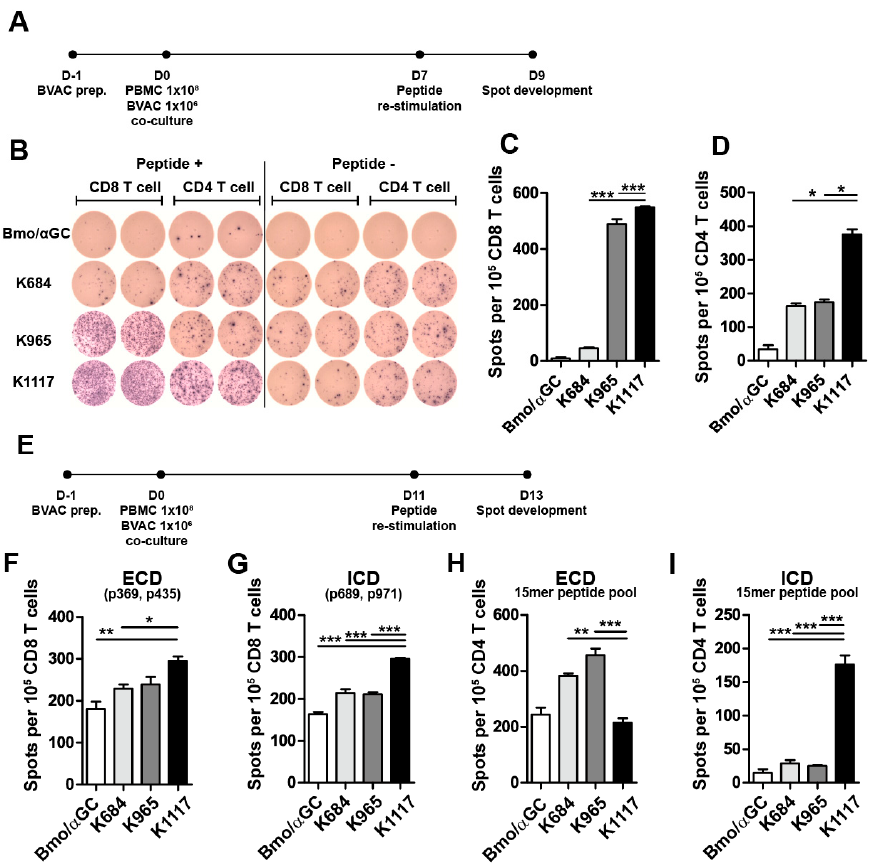
Figure 5. Human T cell responses against HER2. Human PBMCs from human leukocyte antigen (HLA) undefined donors were cocultured with autologous BVACs with engineered antigens ( A ). After 7 days, the CD8 and CD4 T cells were sorted from cocultured PBMCs and restimulated with a total HER2 peptide pool, and IFN- γ production was measured with an ELISPOT assay ( B – D ). ( E ) Human PBMCs carrying HLA-A*0201 were obtained by leukapheresis from a healthy donor and cocultured with autologous BVACs with engineered antigens. After 11 days, the CD8 T cells isolated from cocultured PBMCs were restimulated with HER2 HLA-A*0201-restricted extracellular domain (ECD) or ICD 9-mer peptides ( F , G ), respectively, CD4 T cells were restimulated with the ECD or ICD 15-mer peptide pool, and then IFN- γ secretion was measured with ELISPOT assay ( H , I ), respectively. All data are representative of three independent experiments (* p < 0.05, ** p < 0.01, *** p < 0.001).